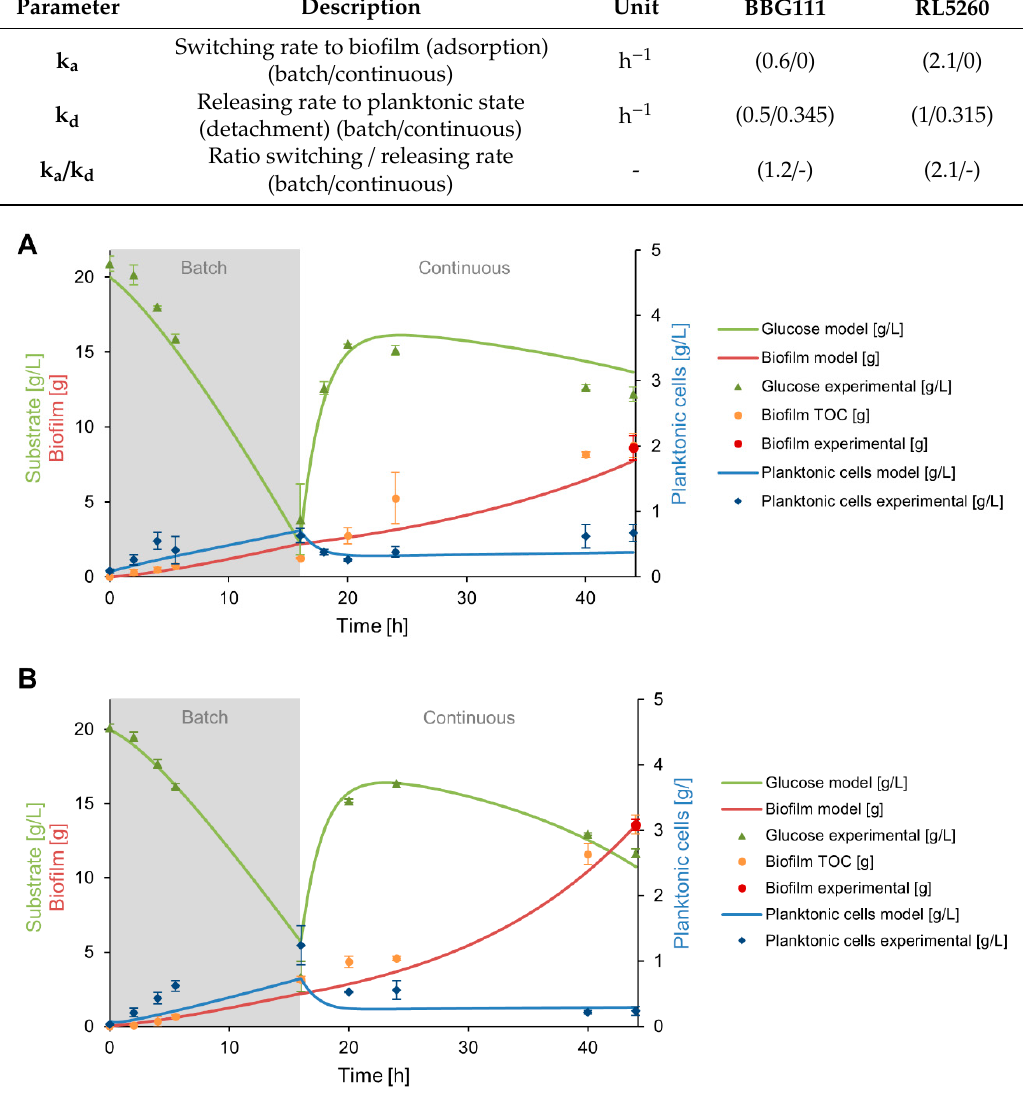
Table 5. Parameters related to cell adhesion and detachment that were introduced into the model. Parameter